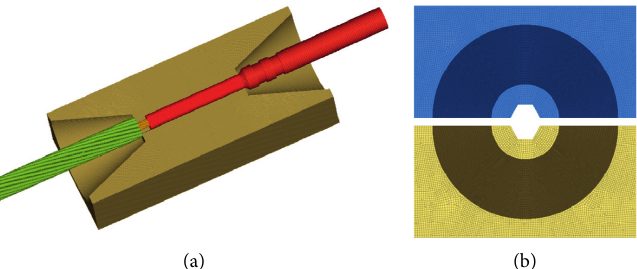
Figure 9: A finite element model for the crimping process of the stamper, steel core, and steel anchor: (a) overall view; (b) cross-sectional view.